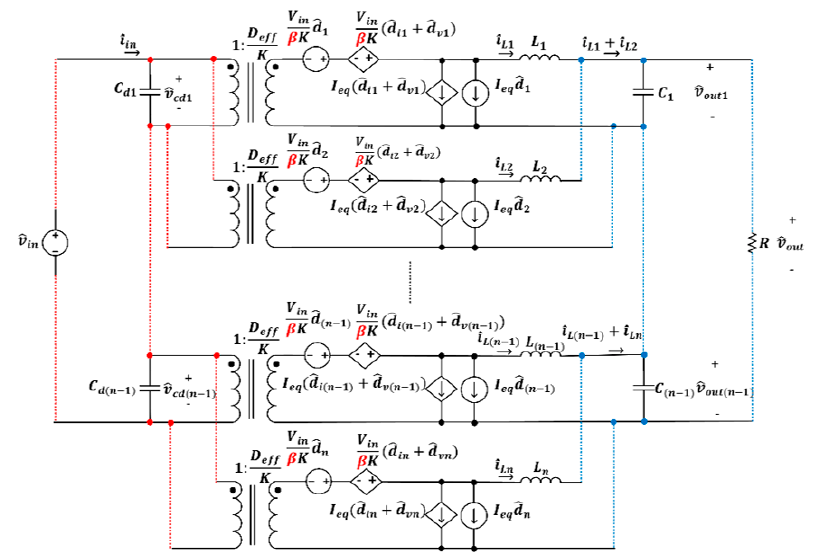
18 of 32 Figure 7. Generalized multimodule DC-DC converter circuit diagram. By ensuring ICS and IVS, the input current per module is (cid:3010) (cid:3284)(cid:3289) 𝜶 , and the input voltage per module is (cid:3023) (cid:3284)(cid:3289) 𝜷 . In which, 𝐼 (cid:3036)(cid:3041) is the input current and 𝑉 (cid:3036)(cid:3041) is the input voltage of the ISIP-OSOP DC-DC converter, and 𝜶 is the number of modules connected in parallel, and 𝜷 is the number of modules connected in series at the input side. Similarly, by ensuring OCS and OVS, the output current per module is 𝑰 𝒐 𝒂 , and the output voltage per module is 𝑽 𝒐 𝒃 . In which 𝐼 (cid:3042) is the output current and 𝑉 (cid:3042) is the output voltage of the ISIP-OSOP DC-DC converter, and 𝒂 is the number of modules connected